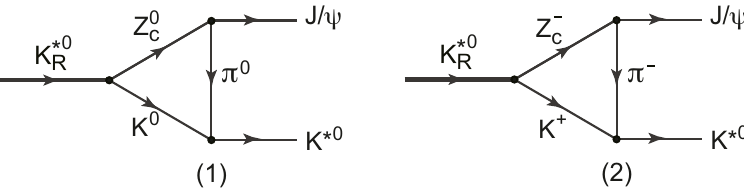
into the (cid:22) D (cid:3) D s channel. R